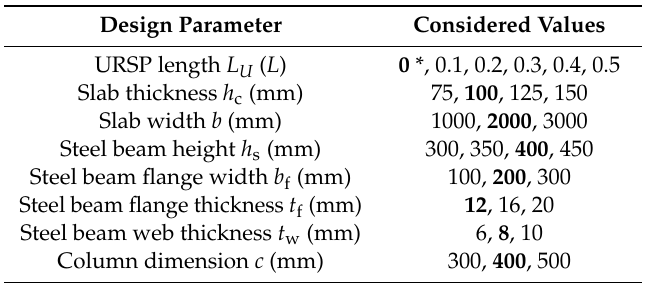
Table 2. Design parameters for load case 2.